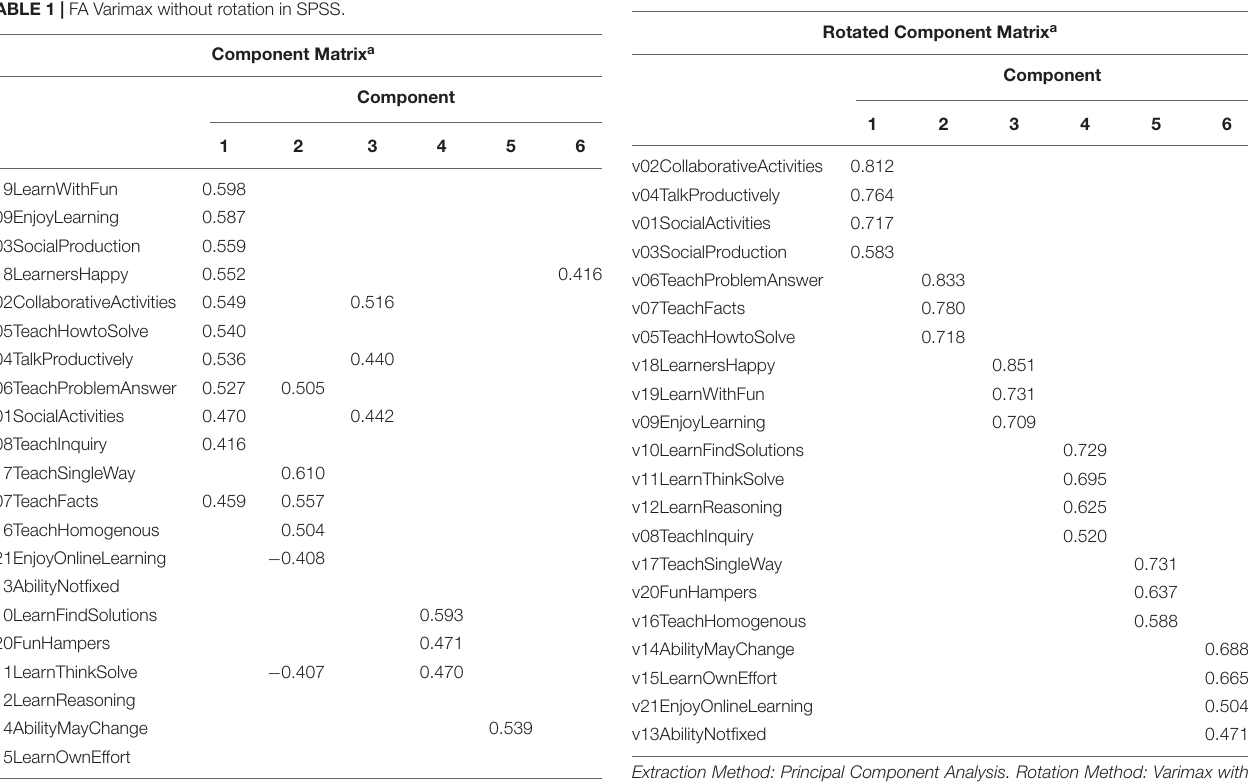
TABLE 1 | FA Varimax without rotation in SPSS.